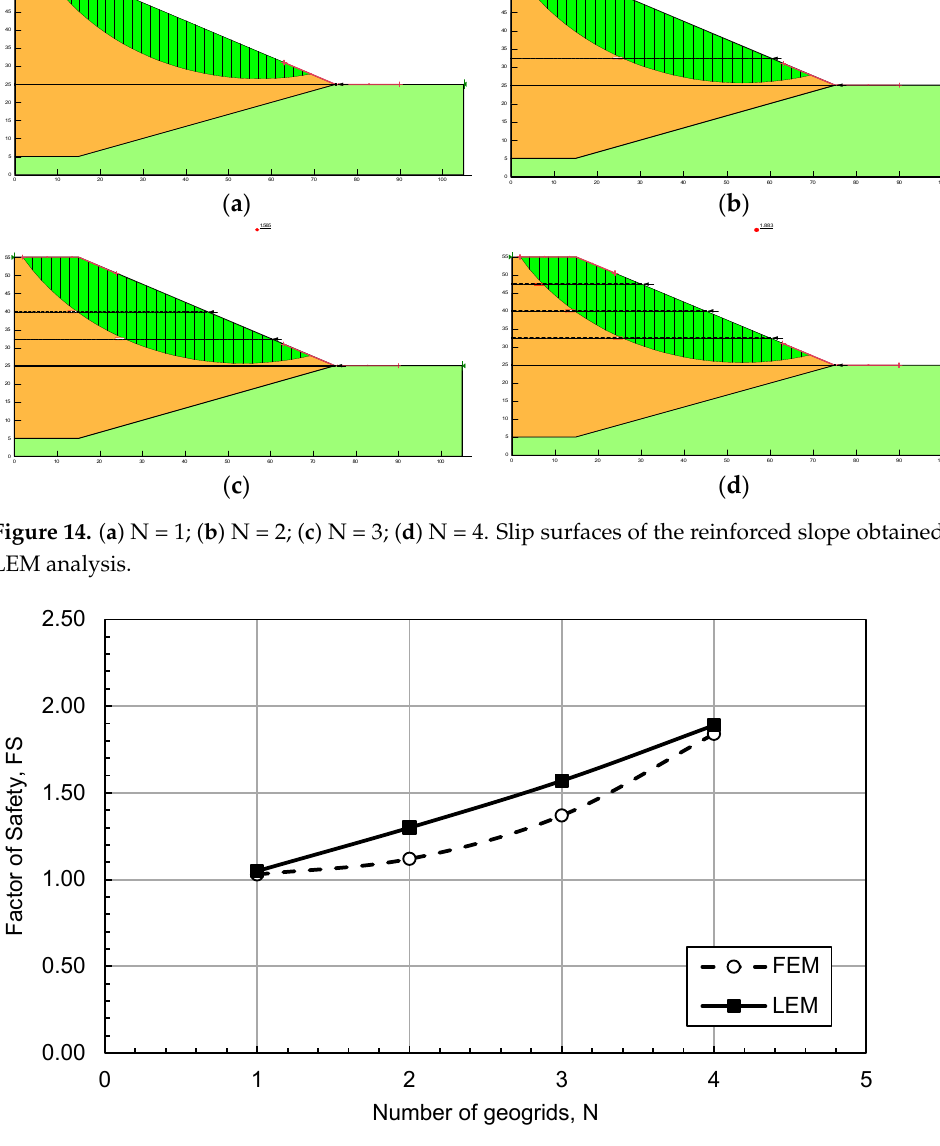
Figure 15. Comparison of FEM and LEM results (N = 4).